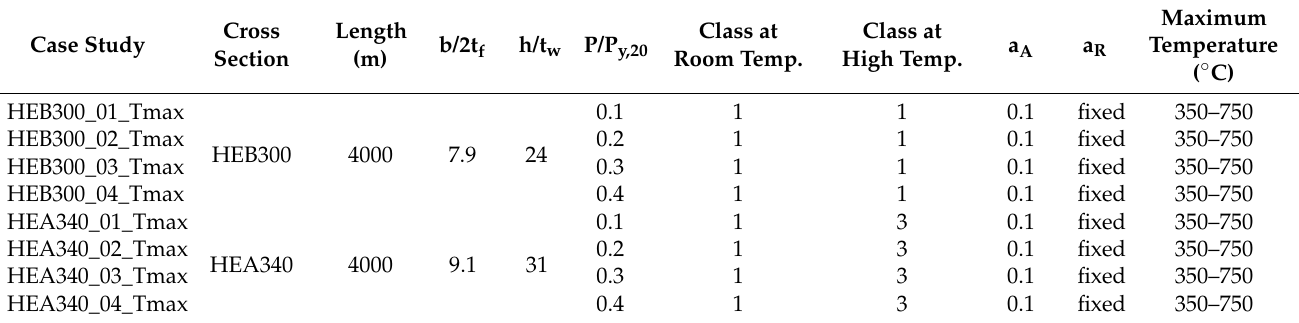
Table 1. Columns with simplified boundary